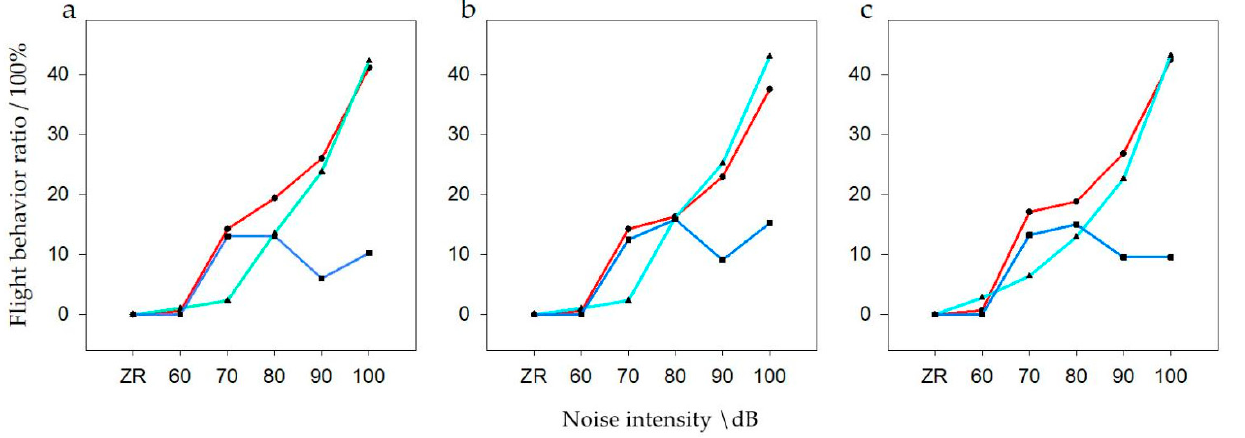
Figure 7. Flight behavior of bean geese (( a ) Population N ; ( b ) Population N1 ; ( c ) Population N2 ) of different noise intensity (ZR (background noise), 60, 70, 80, 90, and 100 dB) and interference distances. The red line of black points in the graphs represent close distances; the light blue line of triangular points in the graphs represent medium distances; the blue line of square points in the graphs represent long distances.